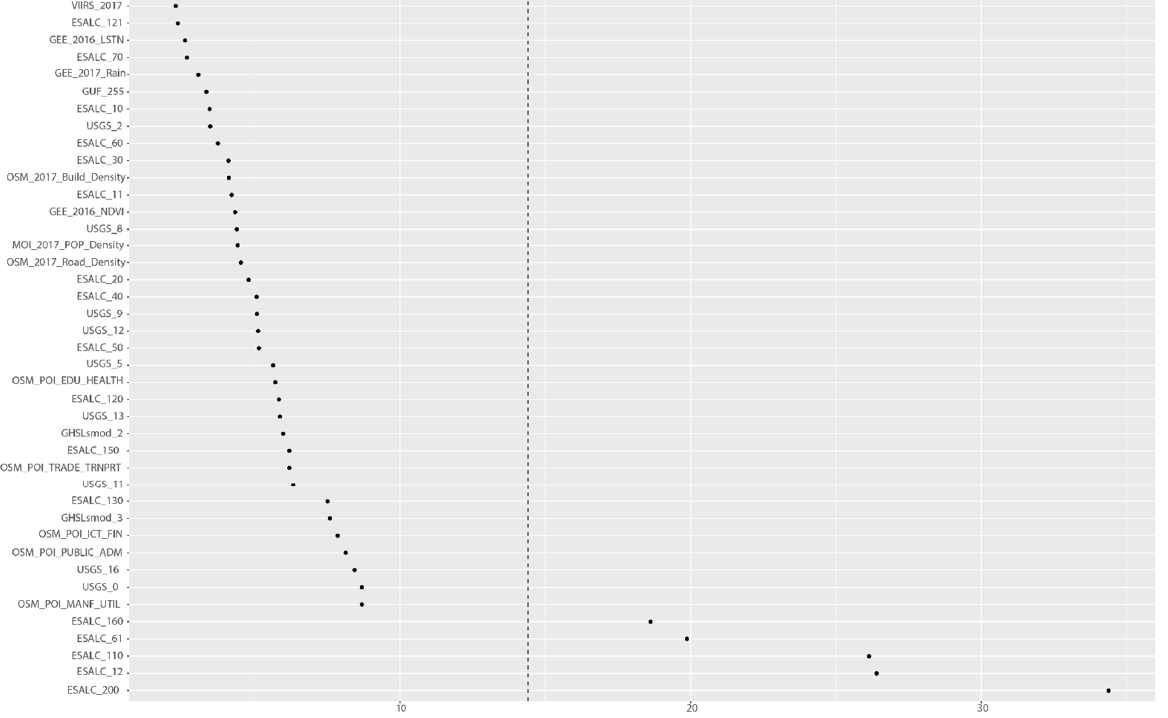
Figure 17. Result of Minimal Depth (MD) analysis on predicting poverty headcount rates of 2017 (based on RF’s outcome). Source: Calculation and graphics generated by authors.